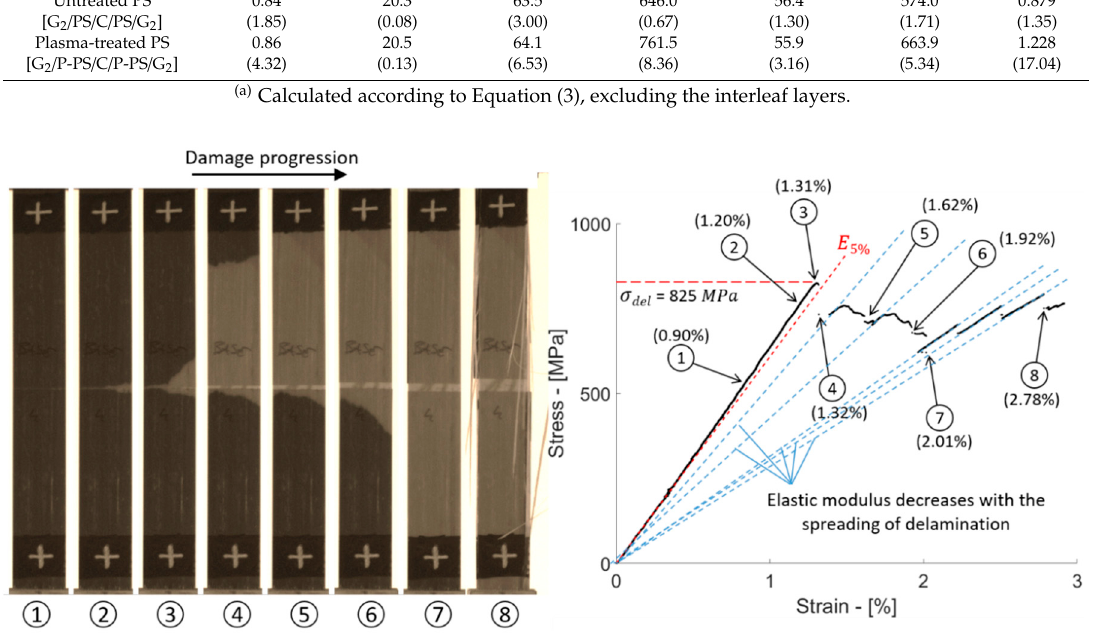
Figure 6. Stages of damage progression in a baseline sample [G 2 / C / G 2 ]. The image shows the progressive spread of delamination with the increasing strain acting on the sample. Table 6. Results of the tensile tests on the hybrid composite material configurations (the CV in % is in brackets below the mean values).